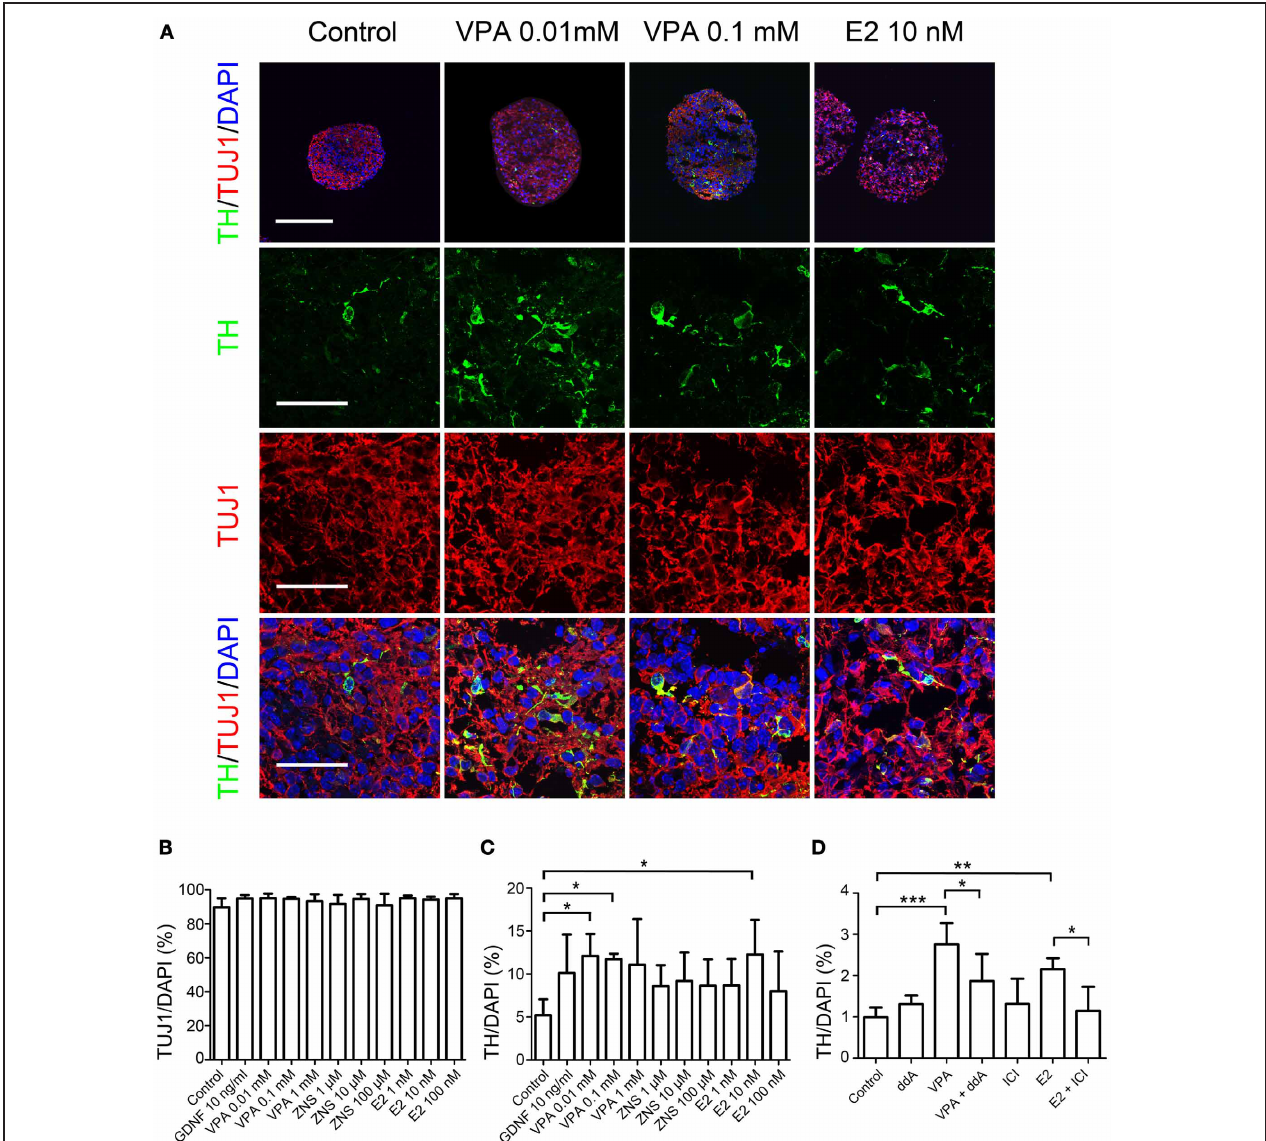
or ICI (2 μ M) was added to the culture medium between days 10 and 14 either alone or in combination with VPA (0.1mM) or E2 (10nM), respectively. (A) Representative immunofluorescent images for TH/Tuj1 in the control and drug-treated cultures. The scale bar applies to all pictures and represents 200 μ m (top) and 50 μ m (lower). (B–D) A comparison of the number of cells labeled for Tuj1 (B) and TH (C,D) per the total number of cells. The data are presented as the mean ± SD. ( ∗ P < 0 . 05, ∗∗ P < 0 . 01, ∗∗∗ P < 0 . 001; n =